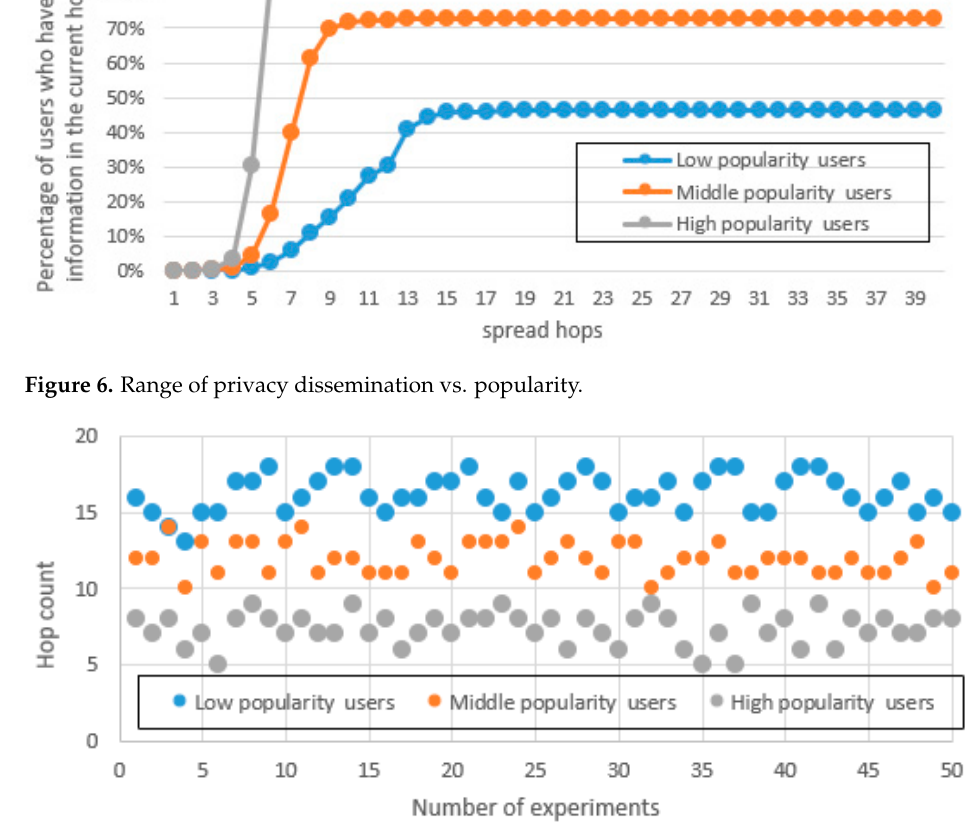
Figure 7. Results in different experiments for different levels of popularity.